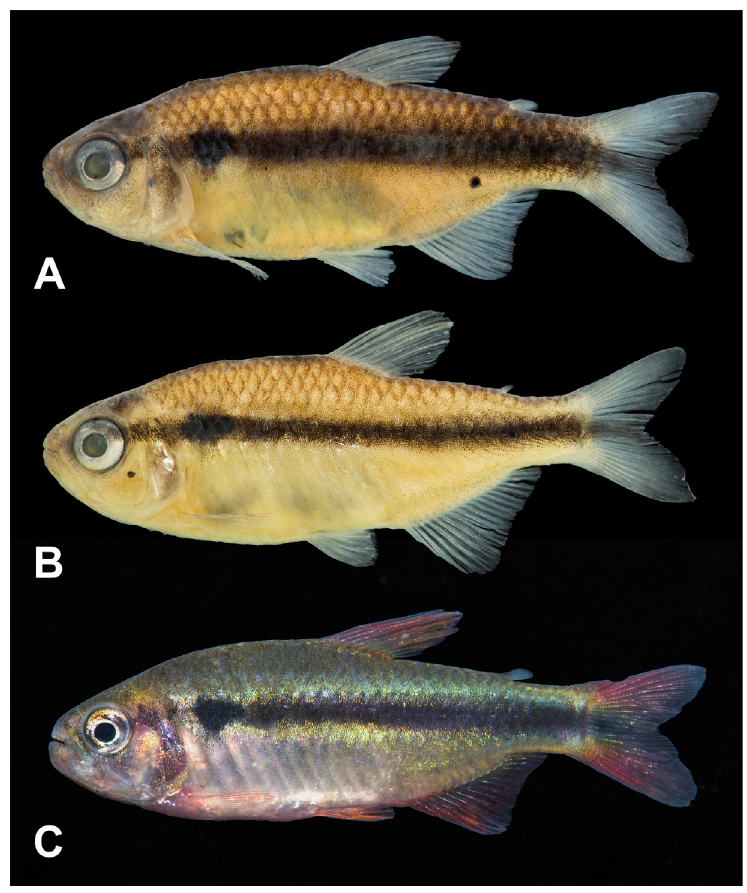
FIGURE 1 | Hyphessobrycon comodoro , Brazil, Mato Grosso State, Municipality of Comodoro, rio Mutum, upper rio Juruena basin: A. Holotype, MZUSP 125904, 29.6 mm SL, male; B. Paratype, MZUSP 125215, 25.3 mm SL, female; C. Aquarium specimen, not measured or